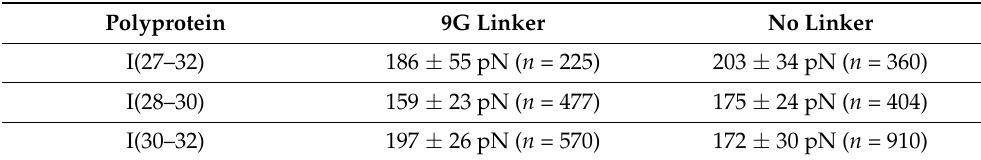
Table 2. Unfolding force of I30 in each polyprotein design.